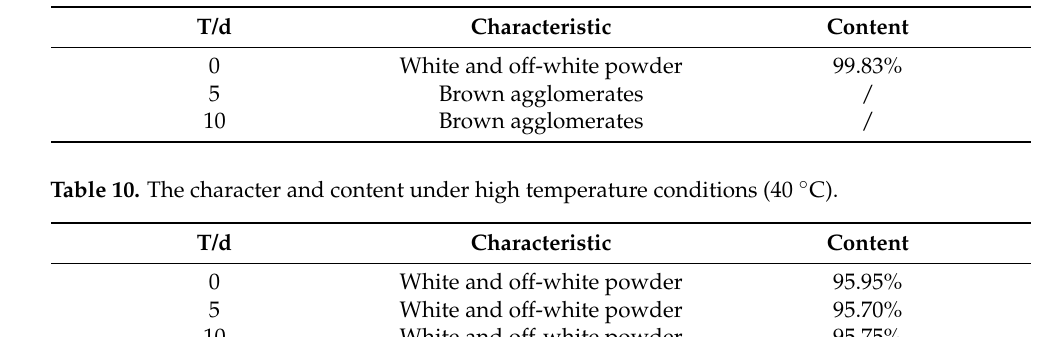
Table 9. The character and content under high temperature conditions (60 ◦ C).